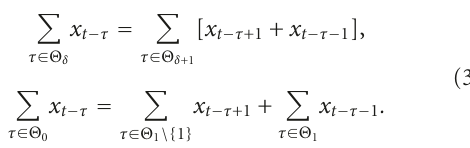
Figure 7: The unicast sessions on the network from Figure 6.